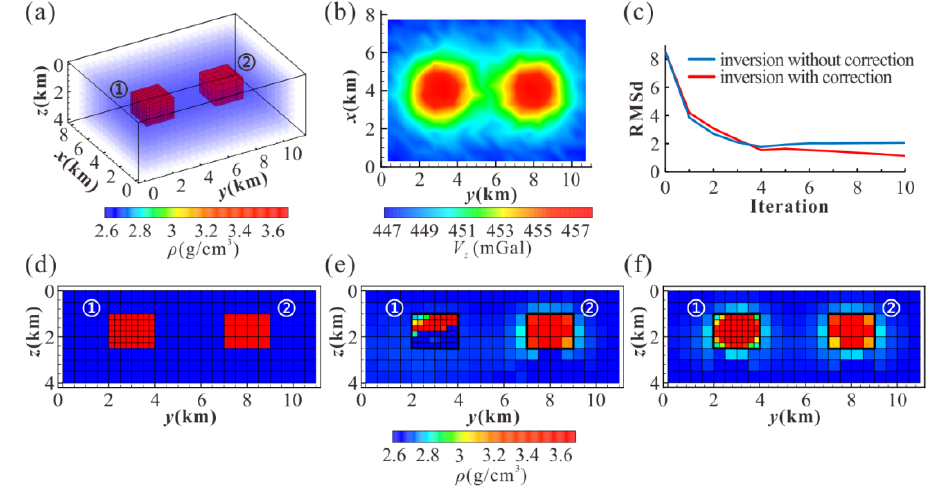
Figure 9. ( a ) Real density model; ( b ) observation data; ( c ) RMSd of inversion; ( d – f ) density slice of the real model and inversion result without/with volume correction at x = 4000 m.